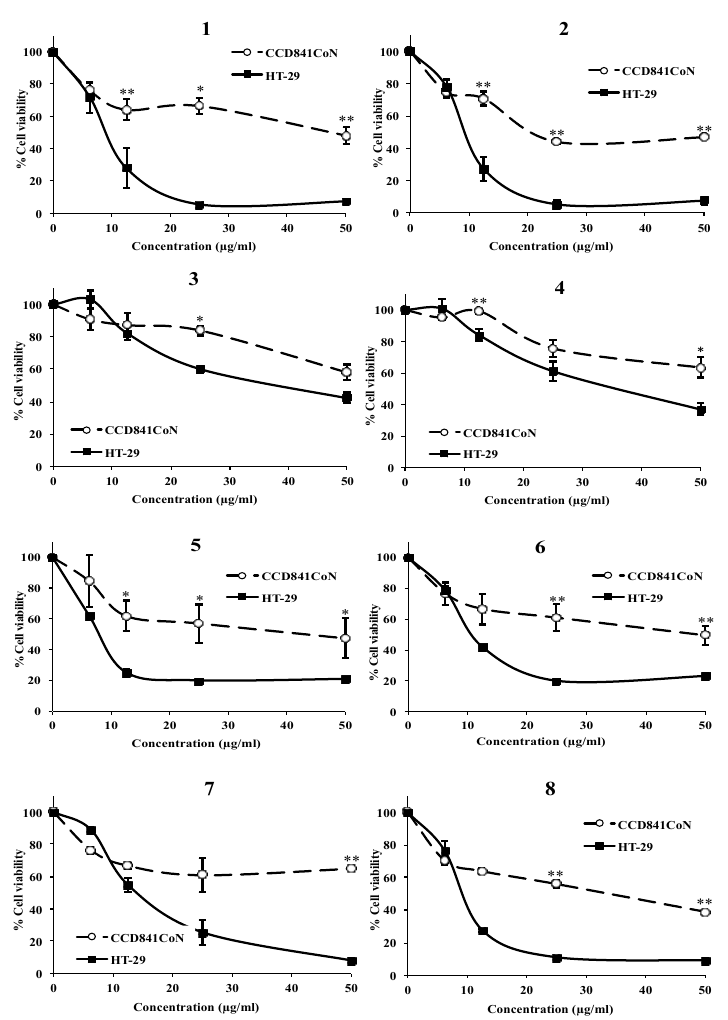
Figure 2. Effect of meroterpenes (AMTs) 1 - 8 at different concentrations on the viability of both HT-29 colon cancer cells and normal colonic epithelial cells CCD 841 CoN after 72 h of treatment. Results obtained by the sulforhodamine B (SRB) assay are reported as the percentage of viable cells (% cell viability). Data represent mean ± SE from three independent experiments. * p < 0.05 and ** p < 0.01 compared with the untreated group.